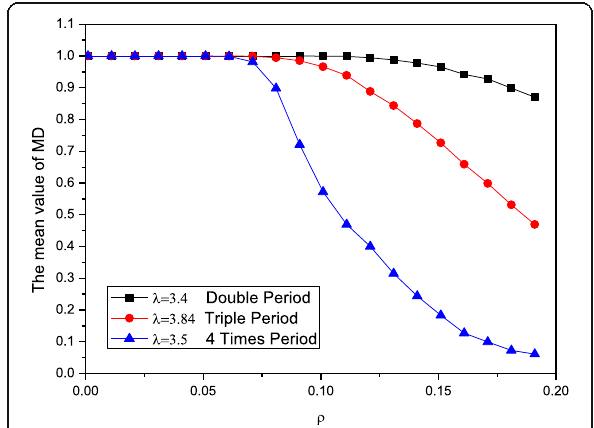
Fig. 4 The MD mean value of three periodic signals ’ surrogate data. Fig. 5 The MD mean value of first group chaotic signals ’ surrogate